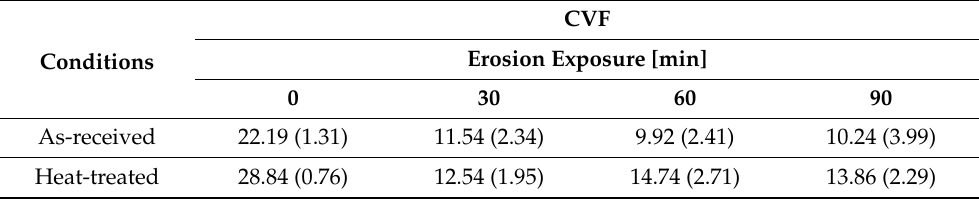
Table 2. CVF values and respective standard deviations (in parenthesis) in the as-received and heat-treated conditions with respect to erosion time. The initial condition before the erosion test is 0 min.